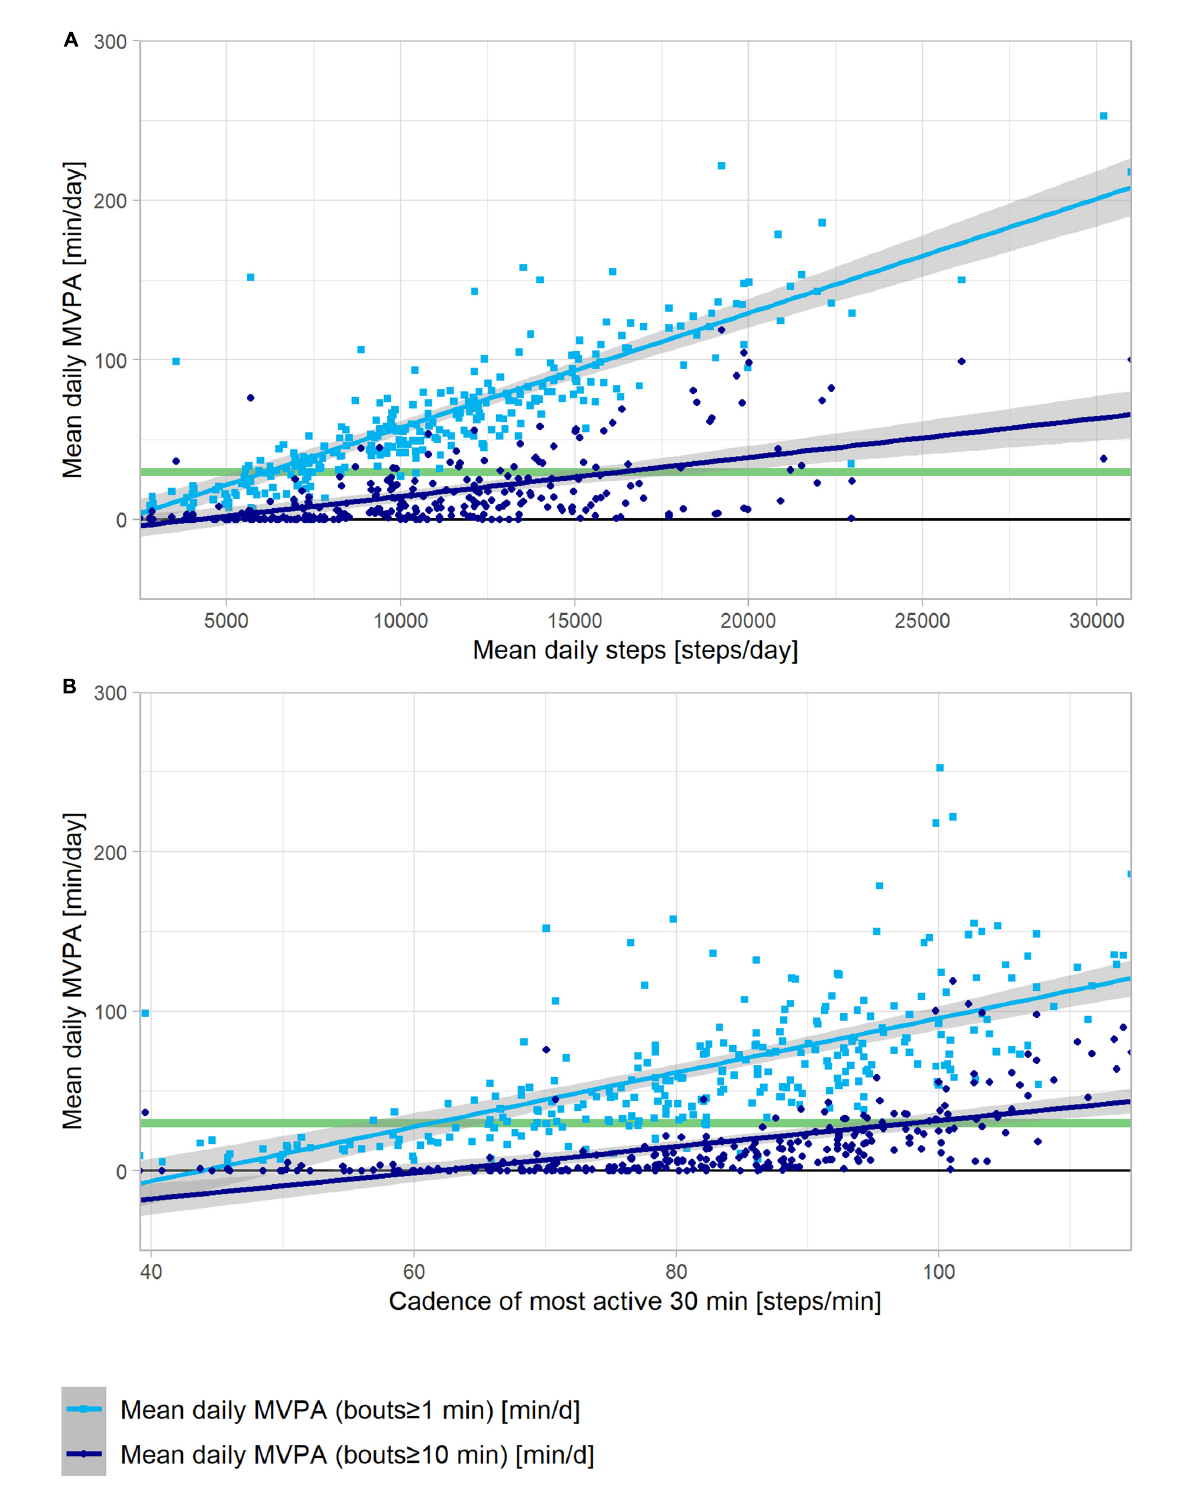
FIGURE3 Linear regressions of MVPA in bouts of ≥ 1 min (light blue squares) and ≥ 10 min (dark blue dots) versus steps per day (A) and versus step cadence of the 30 most active minutes of each day (B) . Each data point reflects mean values over the 18 days for each patient. The 95% confidence interval is depicted by the gray area around the regression